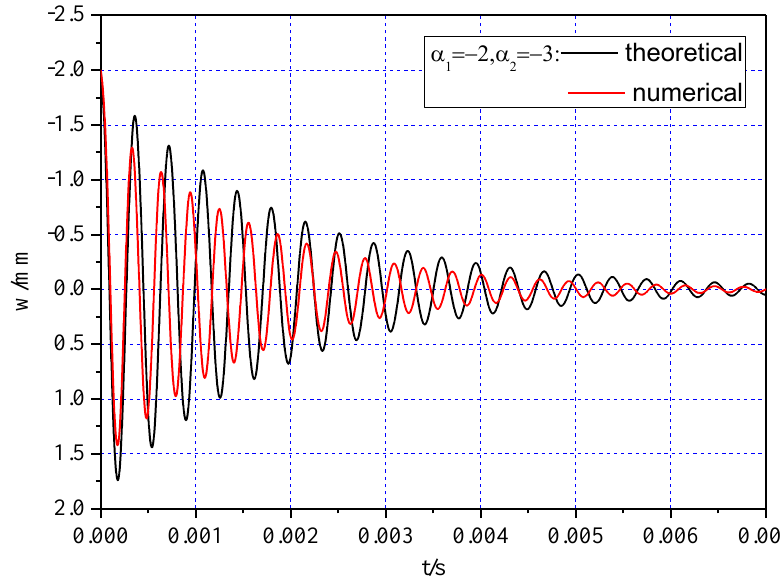
Figure 7. Comparison of two time-displacement curves for E + ( z ) > E − ( z )